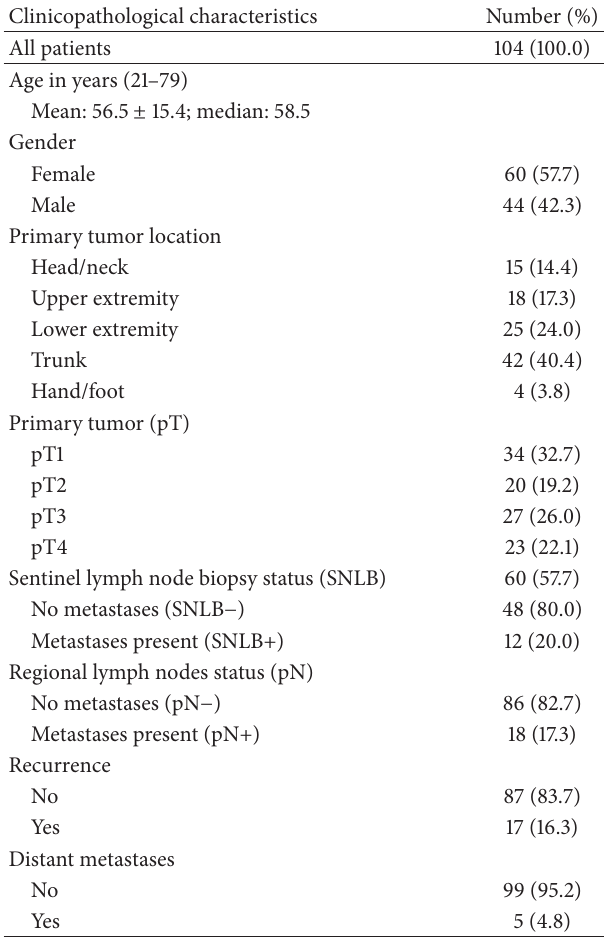
Table 1: Clinicopathological characteristics of the